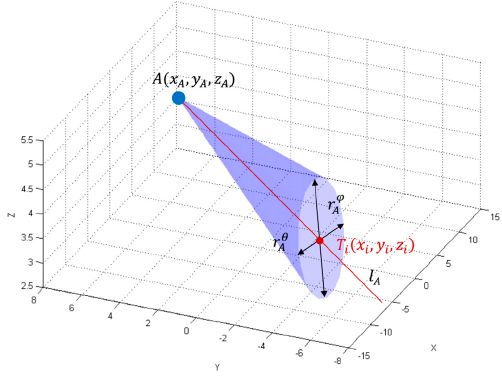
Figure 4. Illustration of uncertainty elliptical cone.